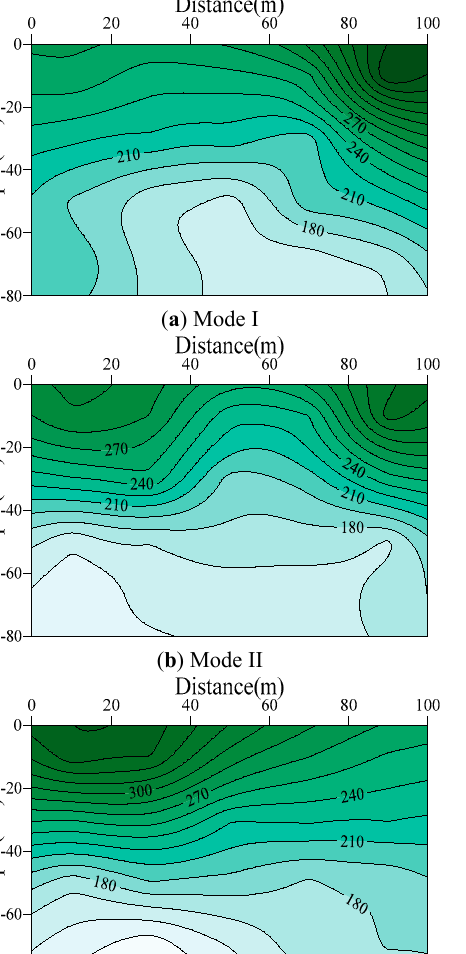
Figure 6. The spatial distribution of the average increment of SO 2 − after irrigation (mg / kg).